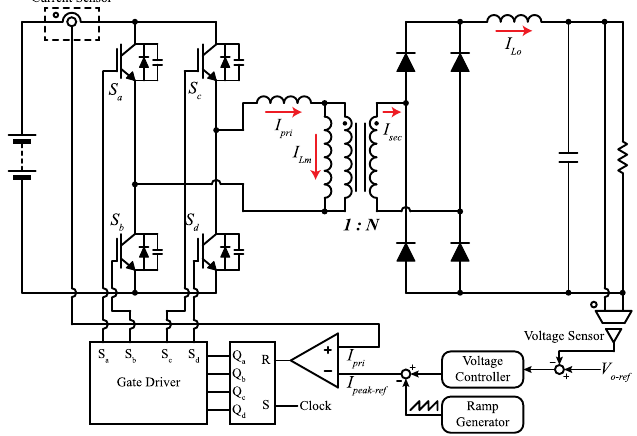
Figure 7. Circuit diagram of PCMC with slope compensation for PSFB